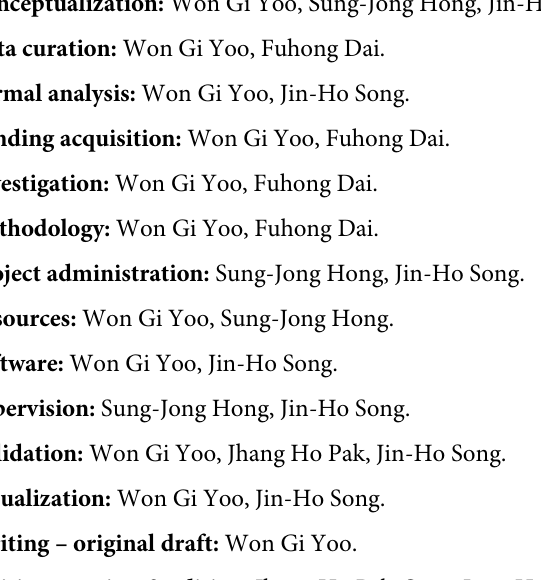
S1 Table. Binding free energies and drug-like properties of 19 compounds from virtual screening against OF-SBAT and IF-SBAT of Clonorchis sinensis using MTiOpenScreen. S2 Table. Binding energy and toxicity risk of 25 compounds with high molecular weight (Mr > 500 Da) against OF-/IF-SBAT of Clonorchis sinensis and OF-/IF-ASBT of Homo sapiens using AutoDock Vina